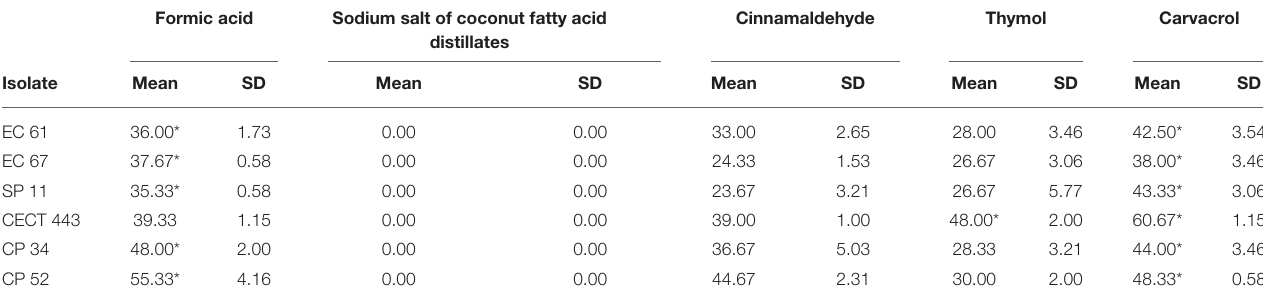
TABLE 2 | Mean of the three measures of inhibition zone diameters (mm) and standard deviation obtained for the disks impregnated with each tested compound against E. coli (EC 61 and EC 67), S. Typhimurium (SP 11 and CECT 443), and C. perfringens (CP 34 and CP52) isolates. Formic acid Sodium salt of coconut fatty acid